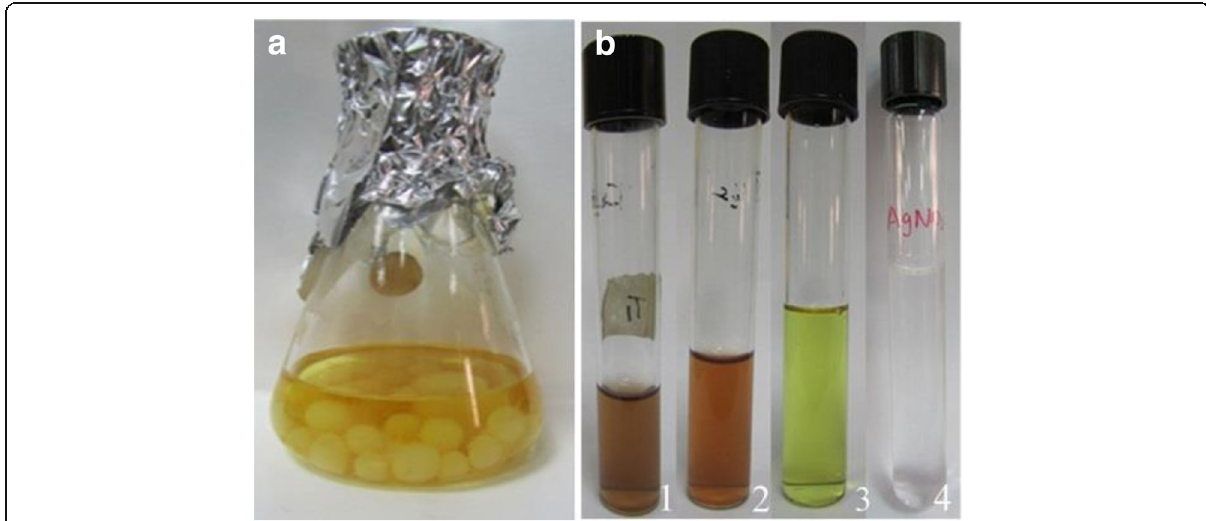
Fig. 1 Culture matt of fungus Trichoderma longibrachiatum in liquid media ( a ). b Biosynthesis of silver nanoparticle color change reaction after exposure to AgNO 3 solution for 96 h: (1) T. viride , (2) T. harzianum , (3) T. longibrachiatum , (4) AgNO 3 1 mM